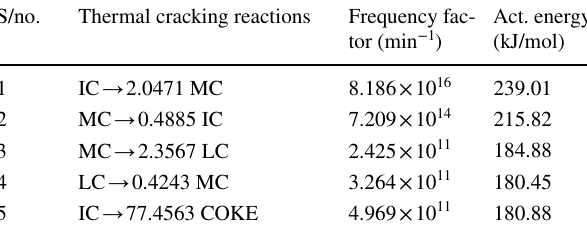
Table 1 Fluid saturation, porosity, and absolute permeability S S O W Porosity Vertical permeability (md)